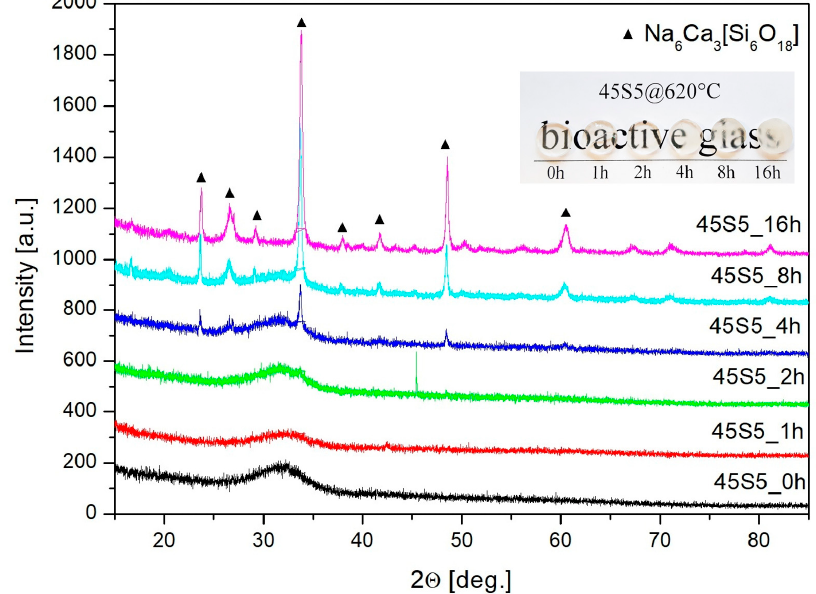
Figure 7. XRD patterns and samples photo (inset) of fabricated 45S5 glass as melted and annealed at 620 ◦ C for 1, 2, 4, 8, and 16